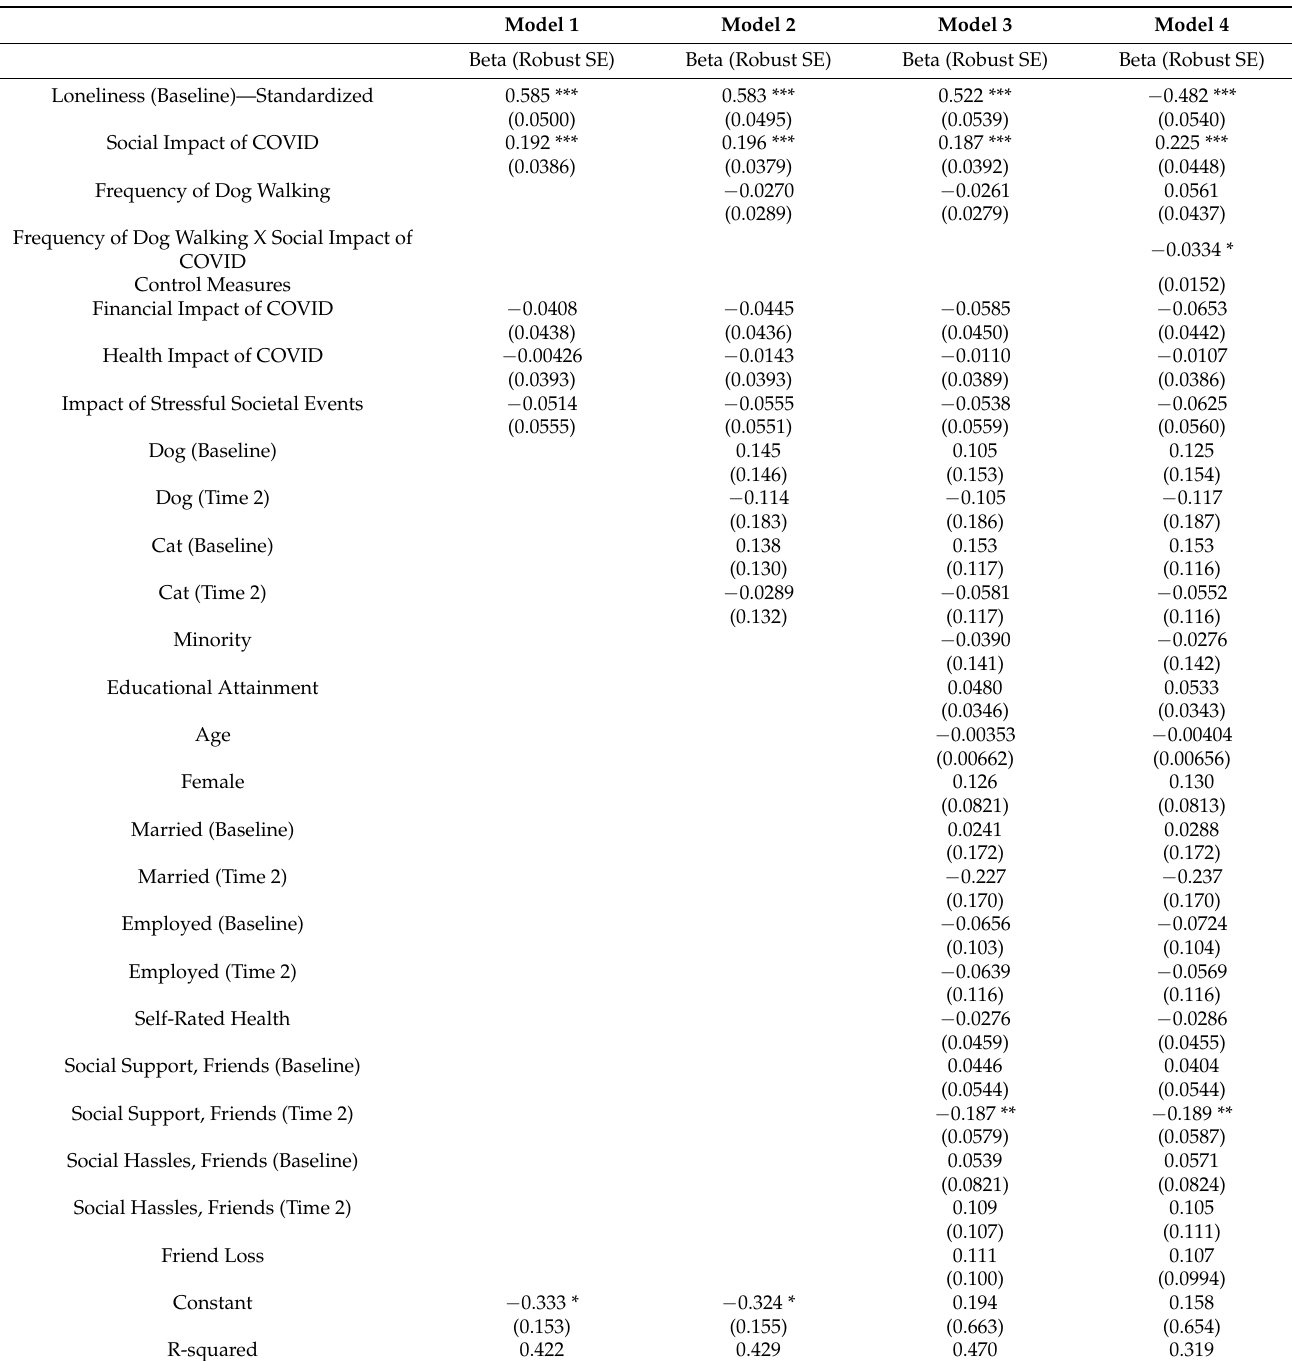
Table 2. Evaluating the Buffering Effects of Dog Walking on the Social Consequences of COVID-19, Predicting Change in Loneliness Pre-COVID-19 relative to Six Months into